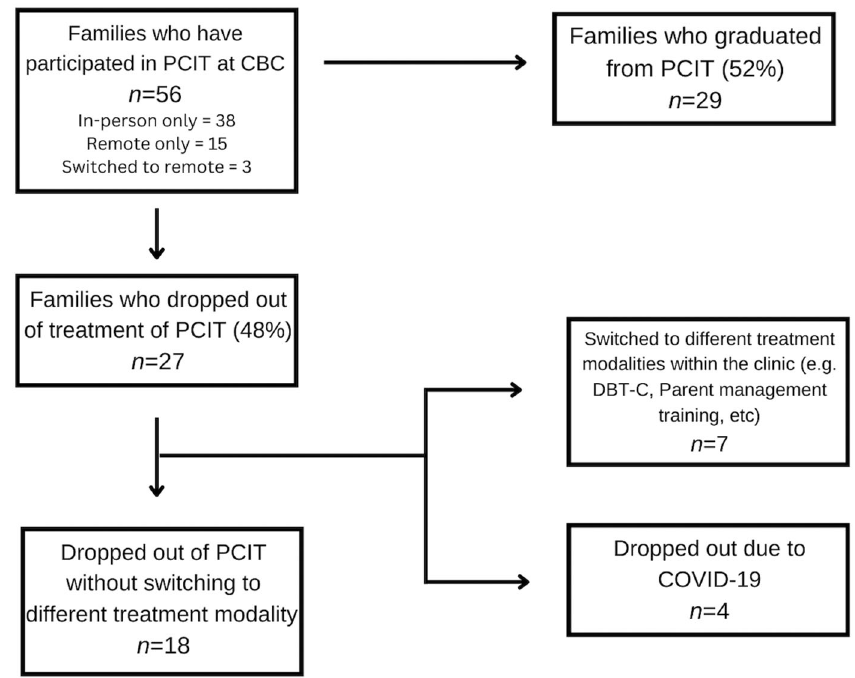
Figure 2. Flow Chart Describing Dropout.